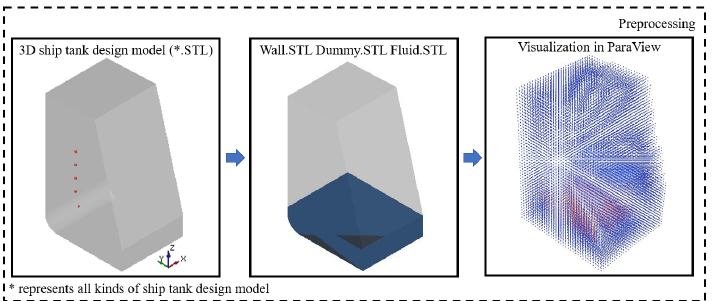
Figure 1. Illustration of preprocessing.